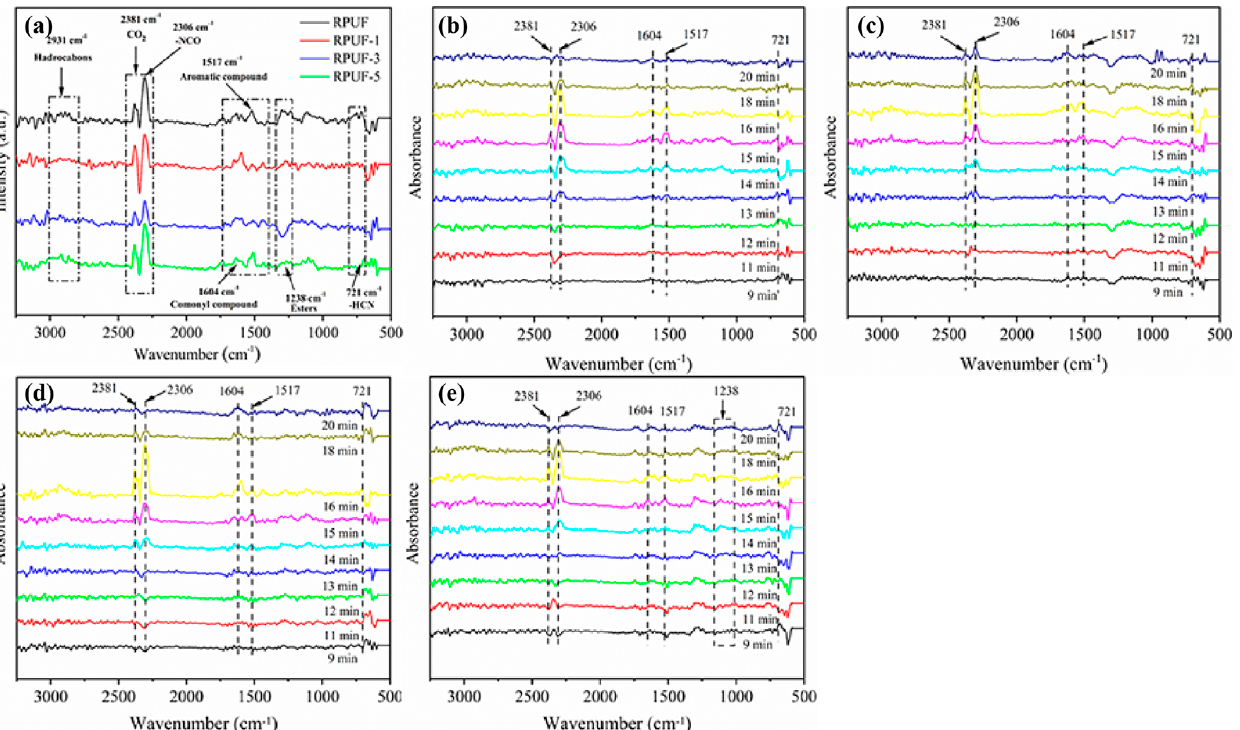
Figure 6. FTIR spectra of thermal decomposition products of RPUF and RPUF-R composites: ( a ) FTIR spectra at T max ; ( b ) RPUF; ( c ) RPUF-1; ( d ) RPUF-3; ( e ) RPUF-5.